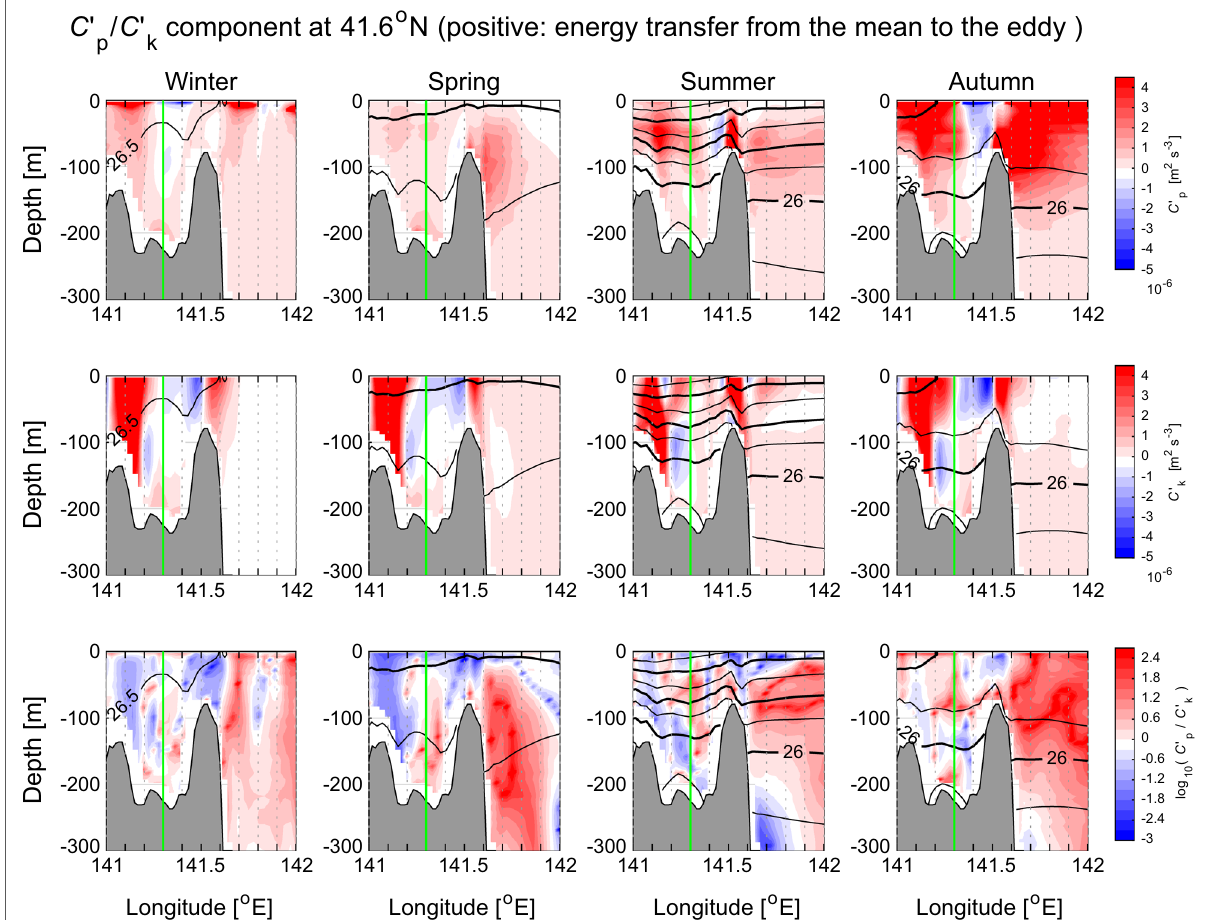
Fig. 12 Vertical distribution of the energy conversion rate calculated from the JCOPE-T DA data during 2019 (upper row: potential energy; middle row: kinetic energy) and their ratio (that of potential energy to that of kinetic energy, lower row) in each season at 41.6°N. Black contours denote the potential density anomaly, σ θ . The green line denotes 141.3°E (see Additional file 1: Fig. S5)